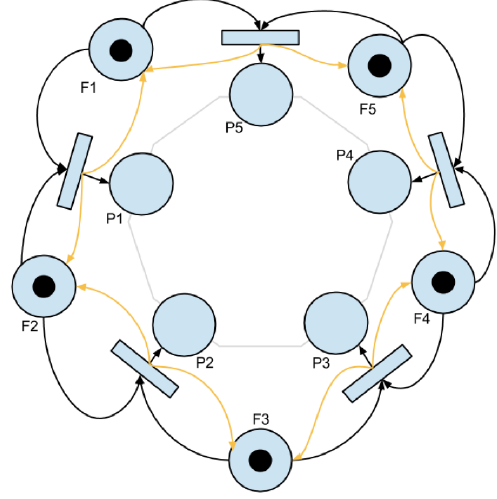
Fig. 10. Model of concurrent behavior for Greenfoot and NetLogo